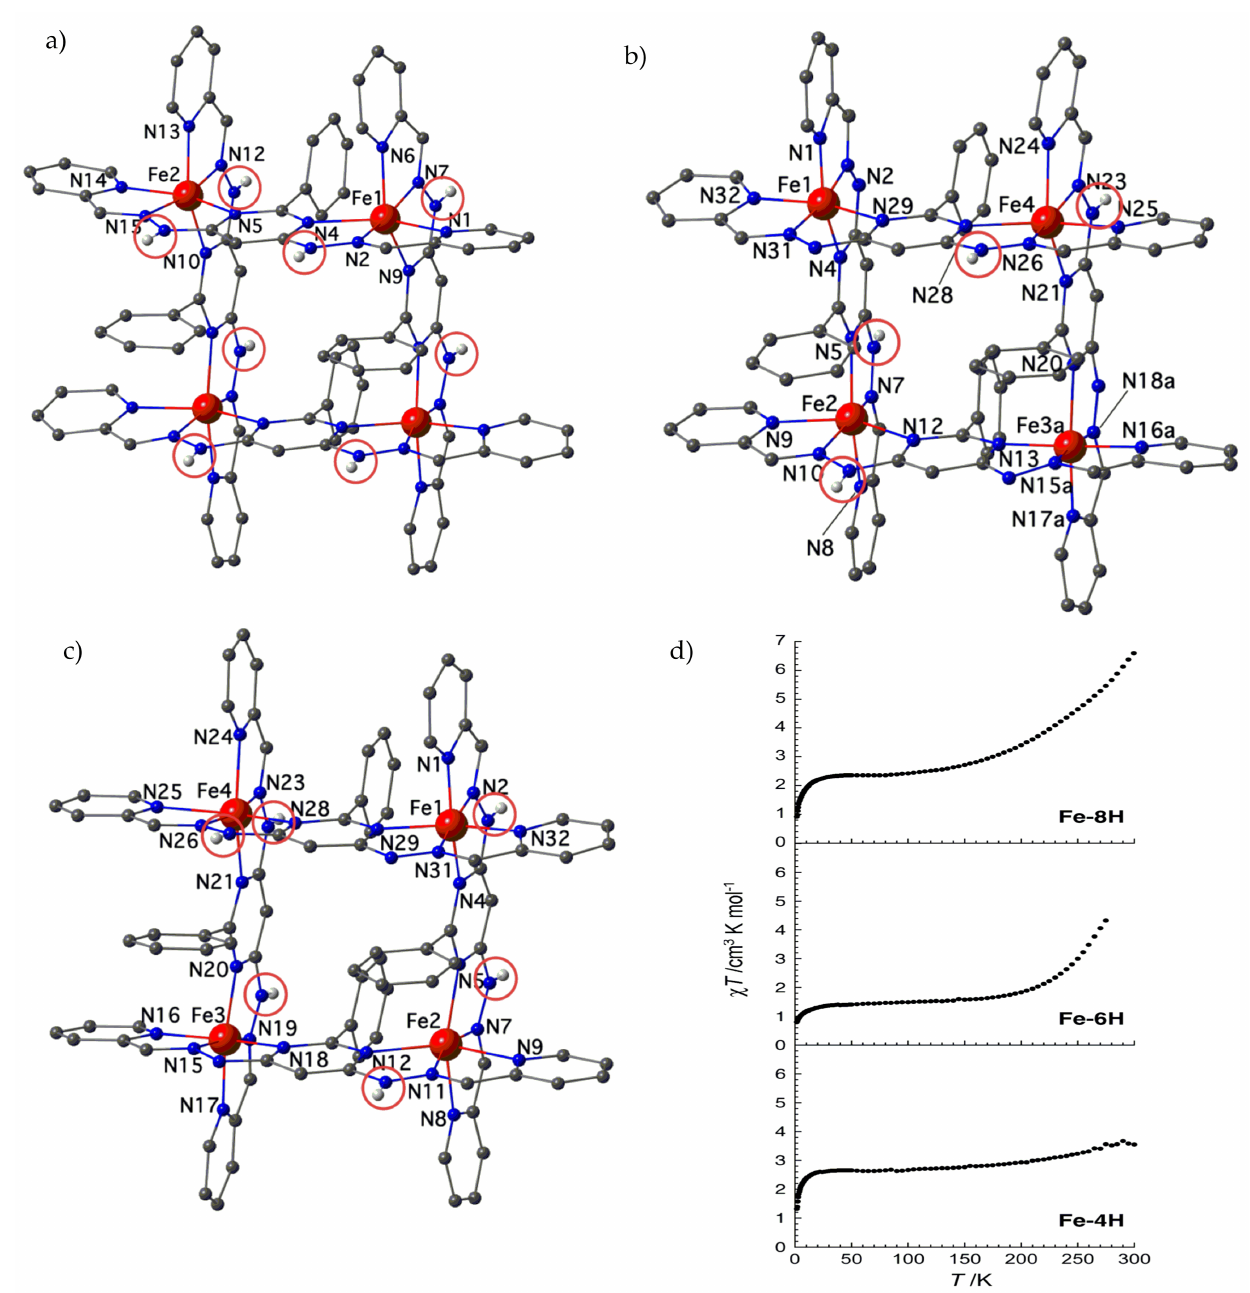
Figure 12. Ball and stick representations of the crystal structures of ( a ) 15 · 2MeCN ( b ) 16 · 8MeCN ( c ) 17 · 12MeCN complexes. ( d ) Temperature dependence of χ M T plot of Fe-8H ( 15 ), Fe-6H ( 16 ) and Fe-4H ( 17 ) complexes. Reproduced with permission from [95]; Published by American Chemical Society,